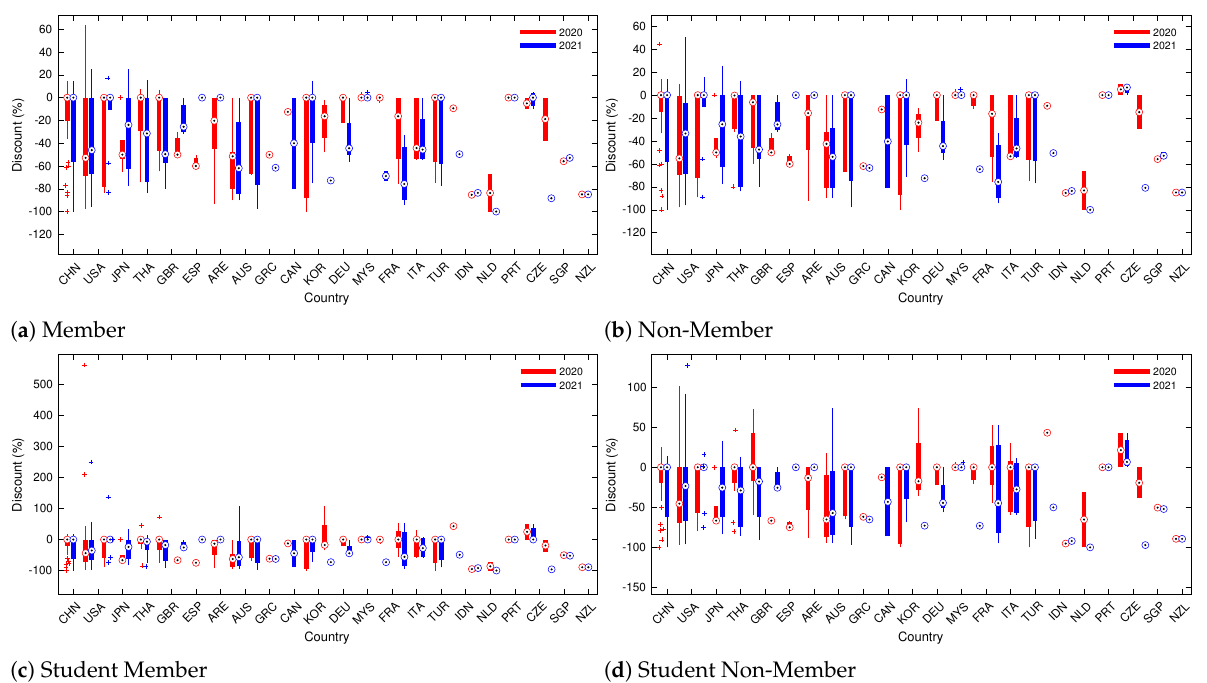
Figure A7. Distributions of the discount rates of registration fees of virtual conferences held in 2020 and 2021 with respect to the